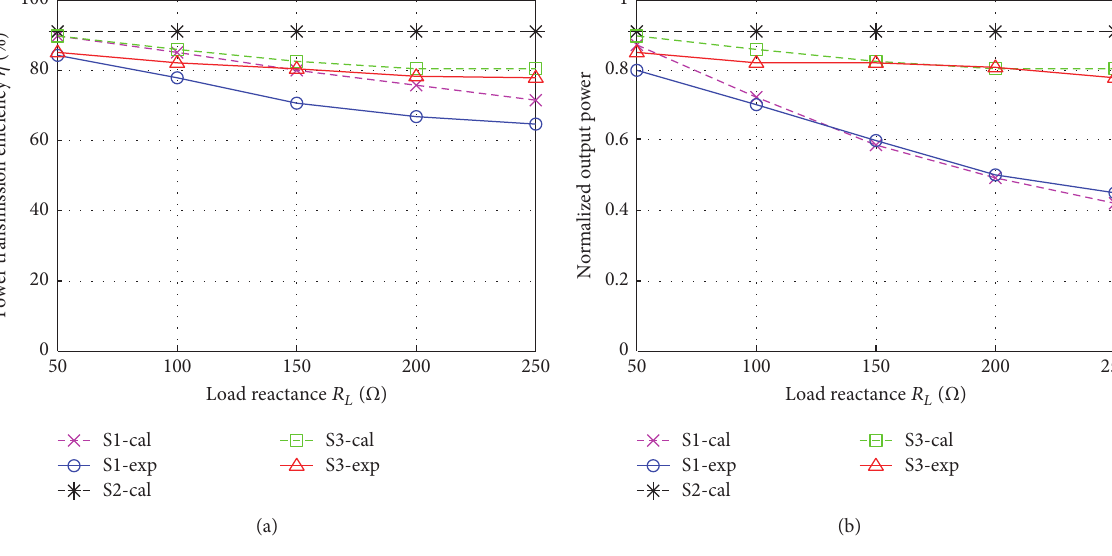
Figure 11: Comparison of three kinds of WPT systems. S1: the original WPT system; S2: the dual-side impedance-matching WPT system; S3: the frequency-tracking and impedance-matching combined WPT system. (a) Power transmission efficiency versus load resistance. (b) Output power versus load